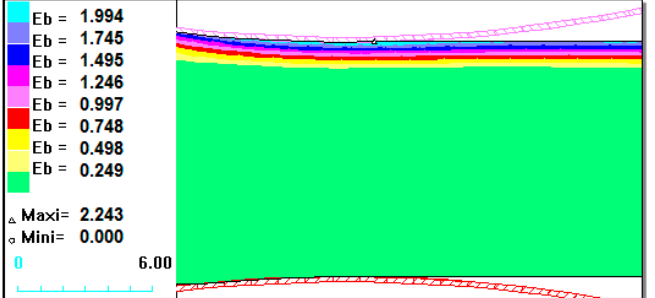
Figure 4. State of strain intensity for the Ni–5%Al alloy coating for 5% relative draft with different coating thicknesses at the upper part rolling band h p = 0.9 mm.